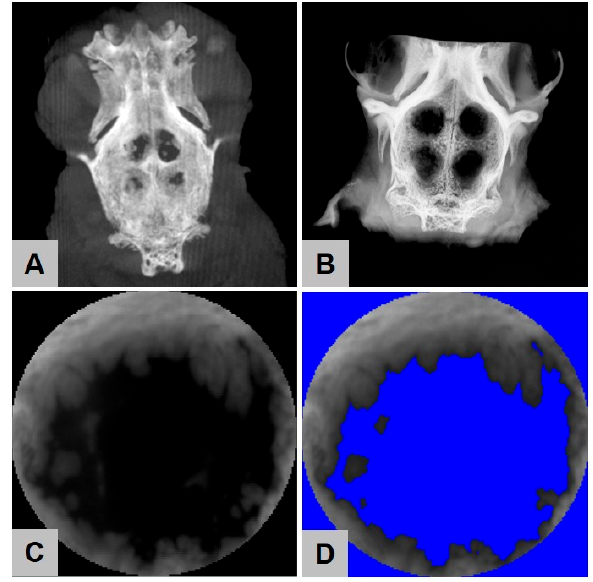
Figure 9. Imaging procedures to detect bone regeneration. ( A ) Three-dimensional DVT reconstruction and ( B ) radiological image as used for bone surface regeneration measurements. Selected circular defect area ( C ) before and ( D ) after application of color threshold.